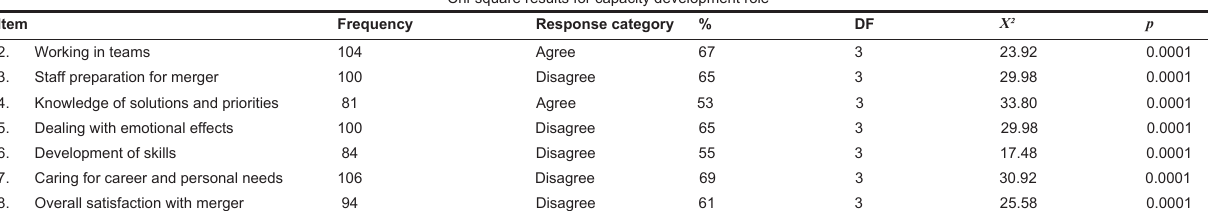
Table 5 Chi-square results for capacity development